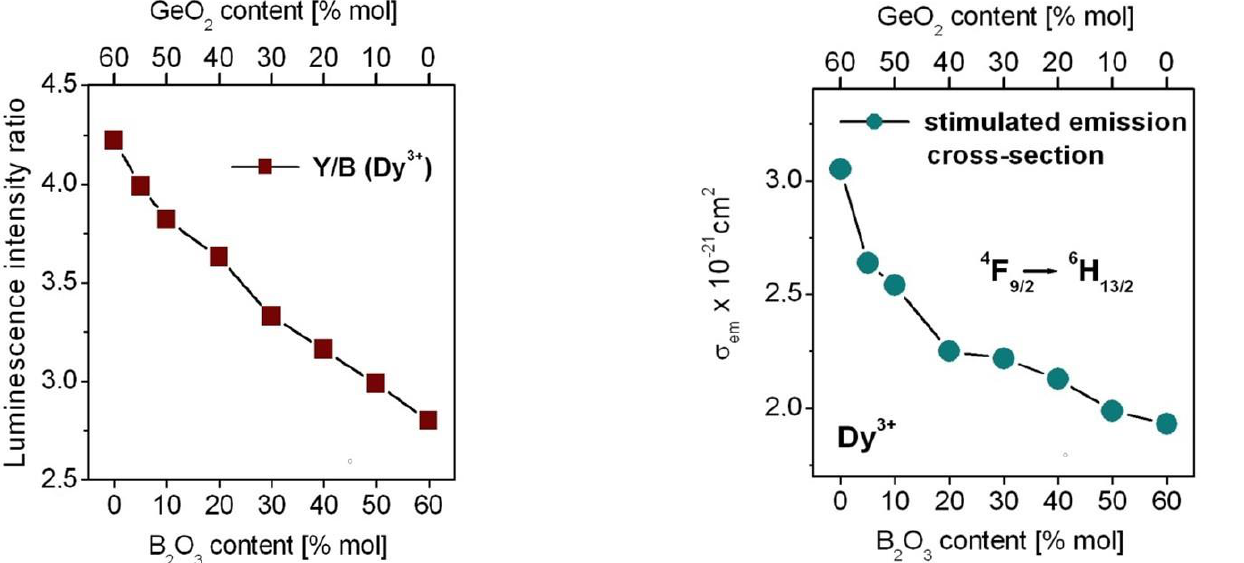
Figure 7. Luminescence intensity ratio Y/B (on left ) and the peak stimulated emission cross-section for the 4 F 9/2 → 6 H 13/2 transition of Dy 3+ ions in borogermanate glasses (on right ).